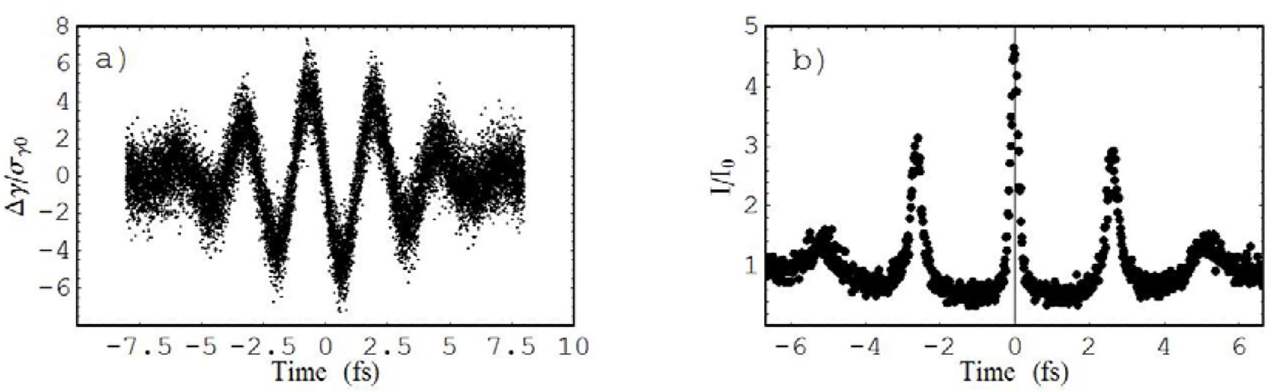
FIG. 5. Energy and peak current modulations produced in interaction with a few-cycle laser pulse. Only a part of the electron bunch affected by the interaction is